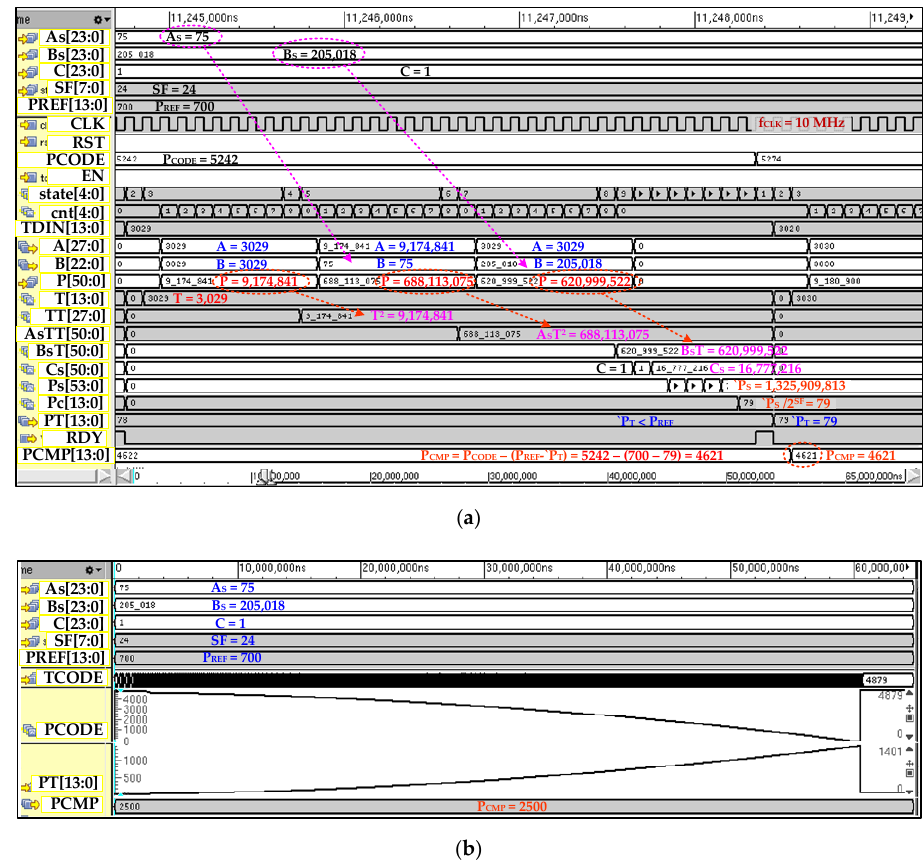
Figure 14. TCC simulation results: ( a ) polynomial computation and temperature compensation for single iteration; ( b ) full temperature sweep from − 40 C to 150 C with constant input pressure.